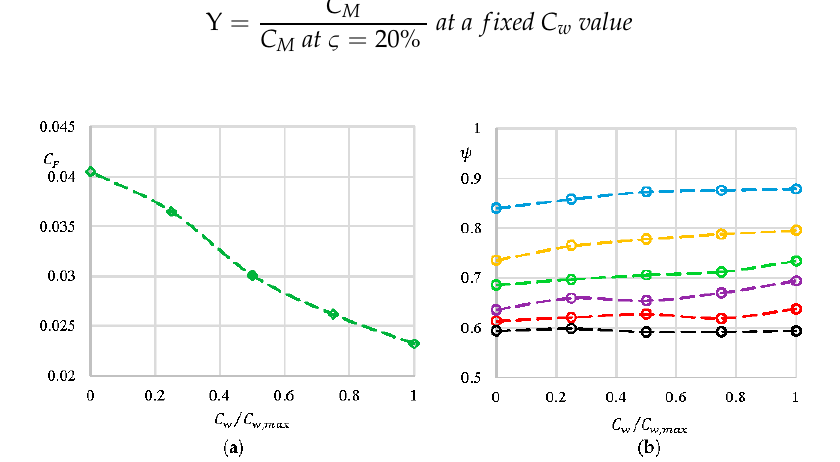
Light green: 𝜍 = 70%,𝑅𝑒 = 0.77 × 10 (cid:2874) , Purple: 𝜍 = 80%,𝑅𝑒 = 0.88 × 10 (cid:2874) , Red: 𝜍 = 90%,𝑅𝑒 = 0.99 × 10 (cid:2874) , Dark: 𝜍 = 100% ,𝑅𝑒 = 1.11 × 10 (cid:2874) Figure 7. Axial thrust coefficient from the measurements: ( a ) Increase of 𝐶 (cid:3007) versus 𝐶 (cid:3050) 𝐶 (cid:3050),(cid:3040)(cid:3028)(cid:3051) ⁄ for 𝜍 = 20% and ( b ) Variations of 𝜓 versus 𝐶 (cid:3050) 𝐶 (cid:3050),(cid:3040)(cid:3028)(cid:3051) ⁄ for 𝜍 ≥ 30% .